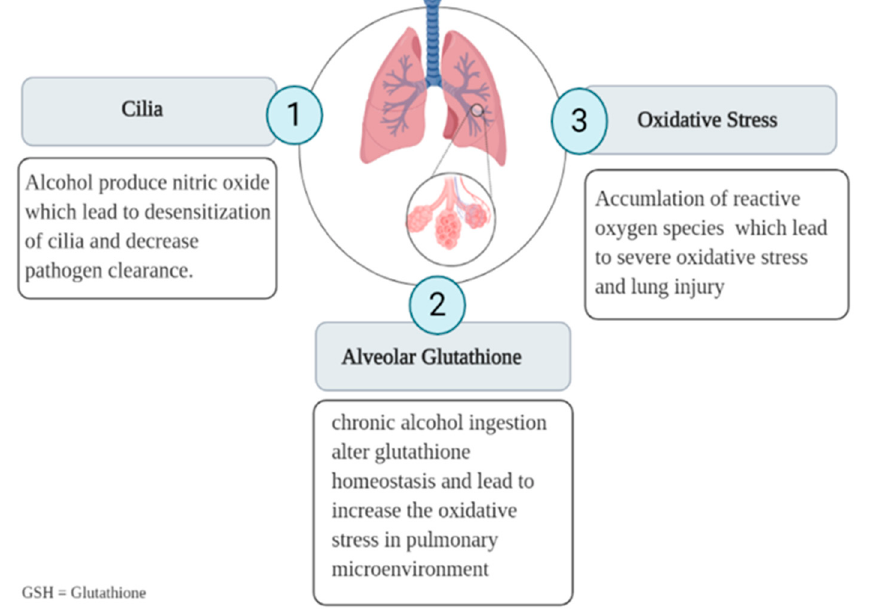
Figure 2. Potential mechanisms by which alcohol might cause lung injury: chronic alcohol consumption might produce nitric oxide, which can lead to desensitization of cilia and decrease pathogen clearance ( 1 ), disturb glutathione homeostasis and cause oxidative stress ( 2 ), and lead to the accumulation of reactive oxygen species ( 3 ). Table 2. Literature review of the possible scenarios of alcohol consumption behavior during the COVID19 pandemic.